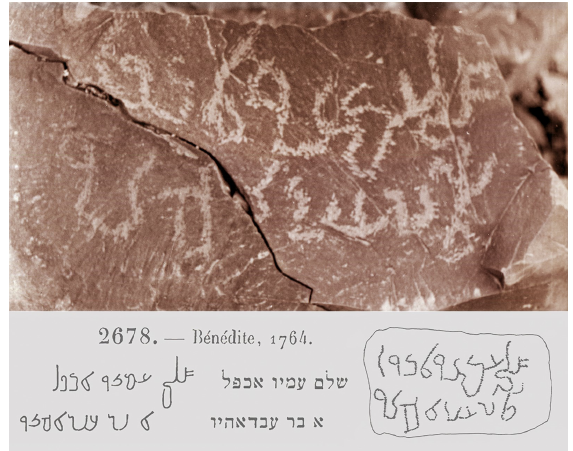
Figure 21 Jebel Moneijah, Nabataean inscription: “Peace (to) ‘ Amiu, high-priest, son of ‘ Abdahiu ” ( CIS II 2, No. 2678, TAB.